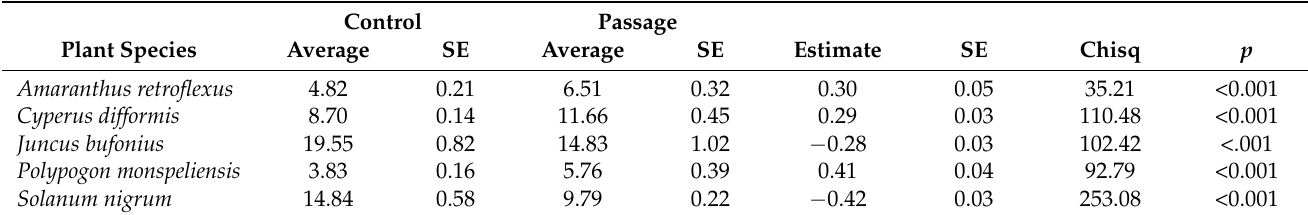
Table 6. Differences in germination time between control seeds and seeds after gut passage through seven